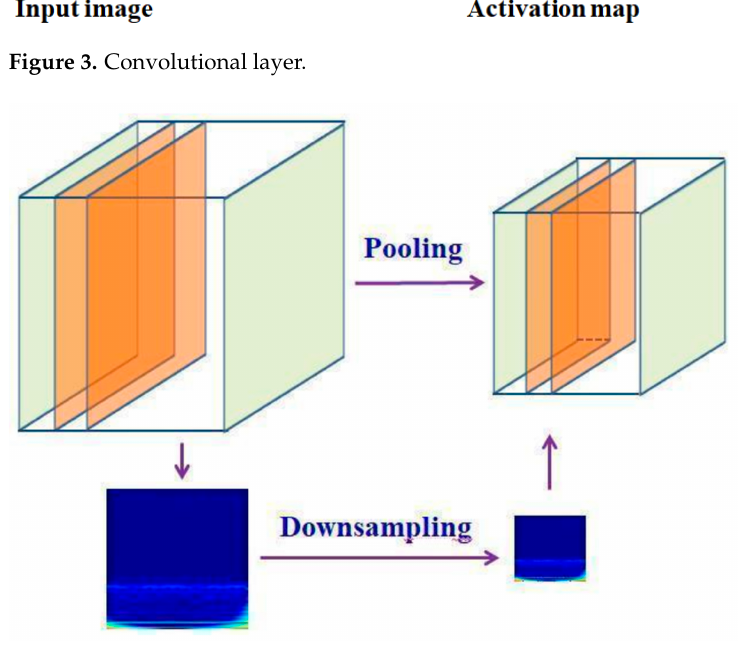
Figure 4. Pooling layer.